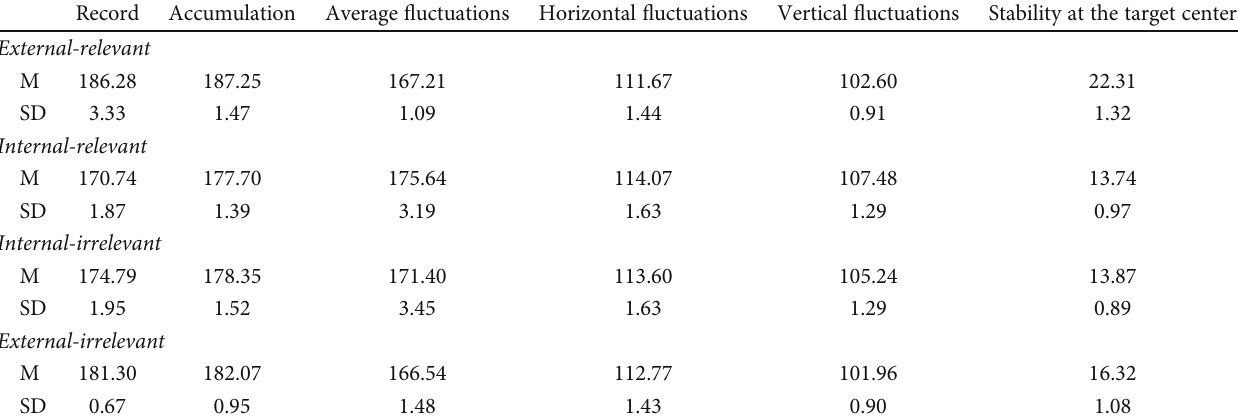
Table 2: Means and standard deviations for the di ff erential attentional focus strategies as a performance precision of military elite shooters.